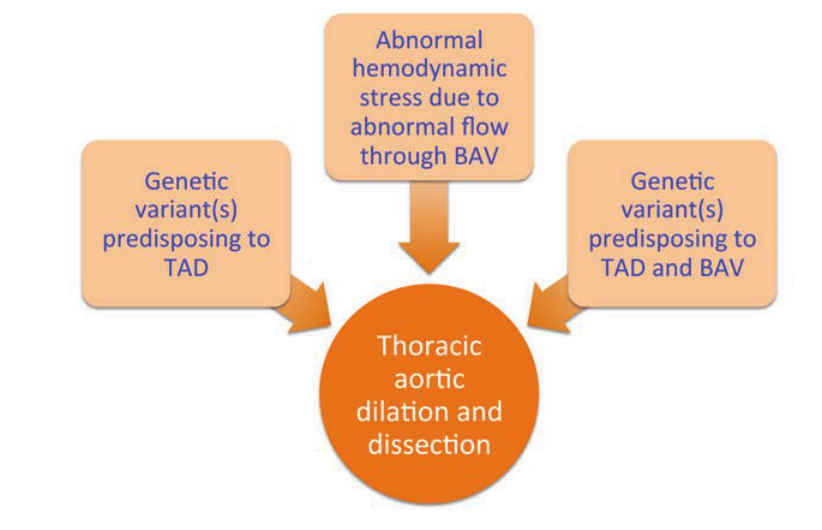
Figure 2. A hypothesis of interacting genetic and hemodynamic causes of bicuspid aortic valve (BAV)-associated thoracic aortic disease (TAD). Common and rare genetic muta- tions cause BAV and TAD that predispose to TAD in the presence of normal and abnormal hemodynamic stresses from the BAV. Combinations of genetic mutation, BAV configura- tion and aortic wall shear stress yield different TAD phenotypes between